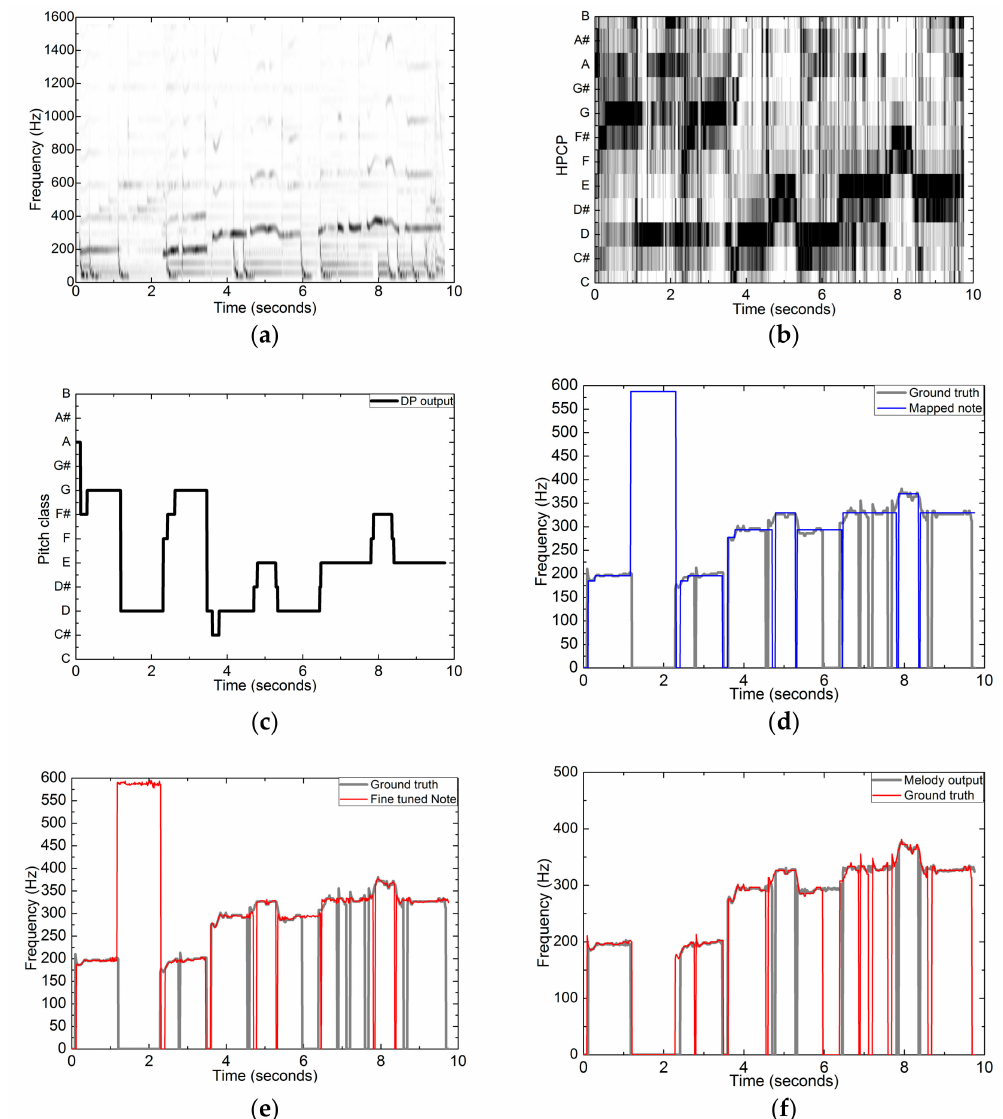
Figure 9. Median results of extracting melody from a polyphonic music recording. ( a ) Spectrogram; ( b ) HPCP; ( c ) chroma-level notes; ( d ) coarsely mapped pitches; ( e ) fine-tuned pitches; ( f ) melody